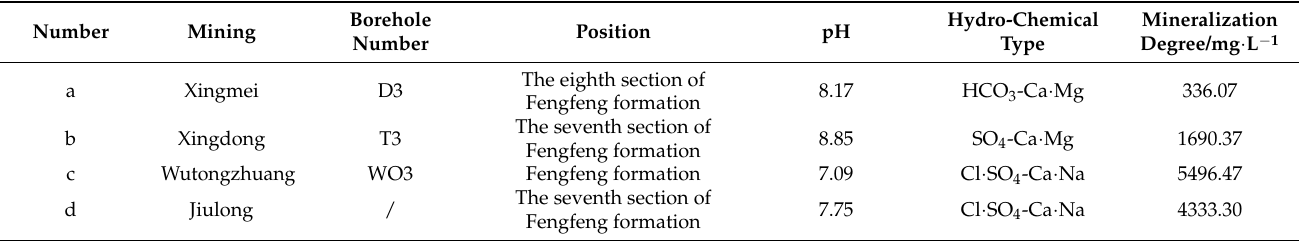
Table 2. Hydro-chemical type and mineralization degree of an MOL aquifer in part of China’s Hanxing mining area.